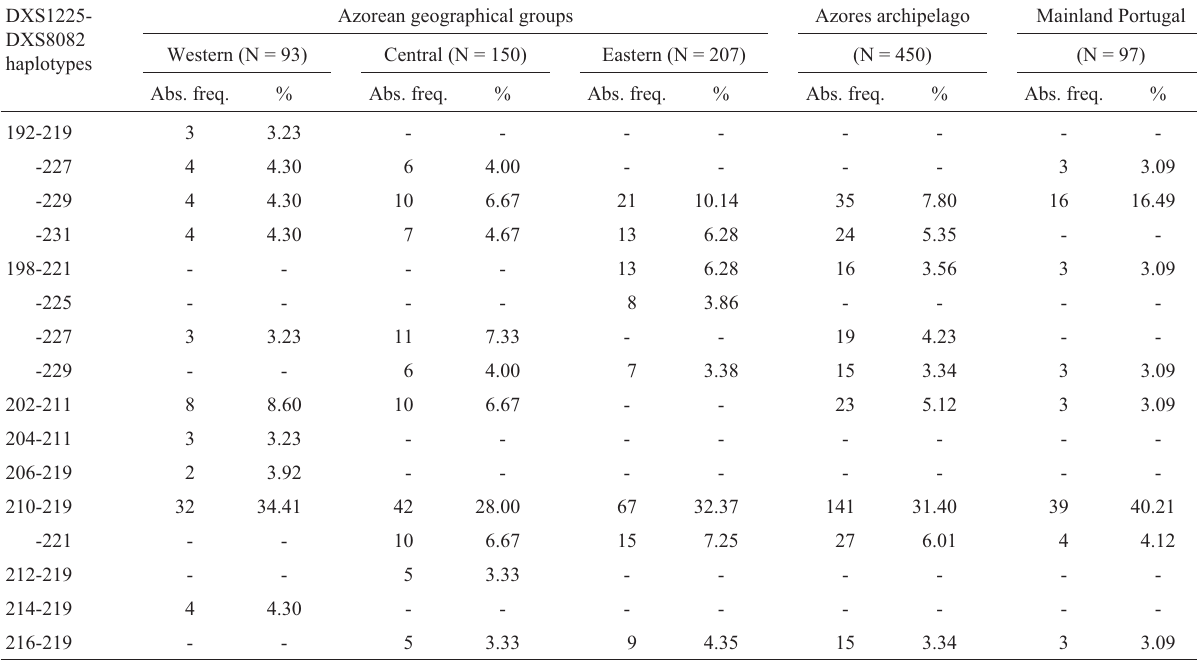
Table 3 - Common haplotypes of micro-satellite loci DXS1225-DXS8082 with frequency (cid:3) 3% for Azoreans and mainland Portuguese populations. DXS1225- DXS8082